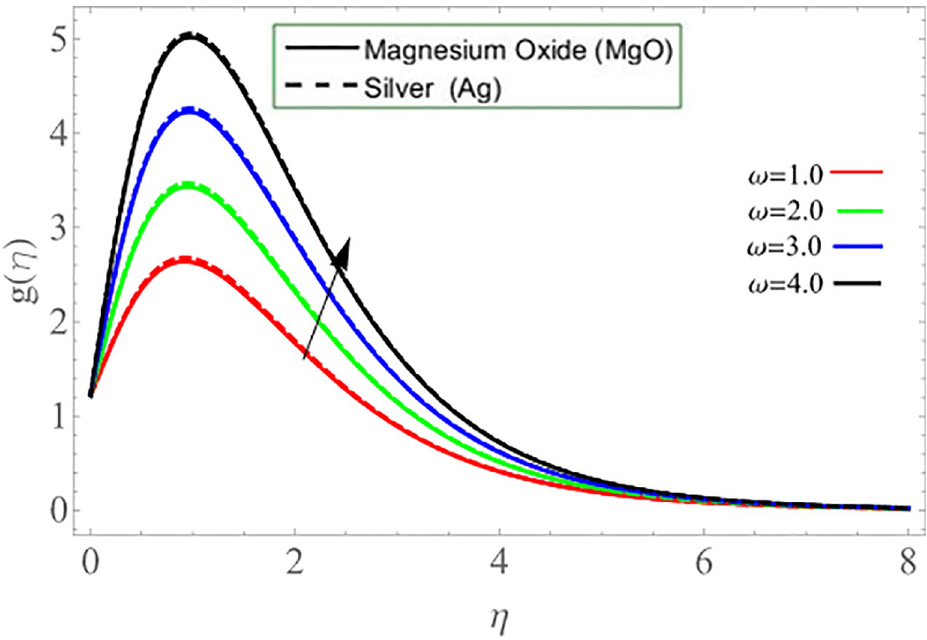
Table 1 elaborate the thermophysical characteristics of silver, base fluid, and magnesium- oxide. Table 2 revealed the comparison between PCM and bvp4c method numerically for all velocities. It can be presumed that the parametric continuation method has strong conver- gence versus other numerical method. Tables 3 and 4 display the influence of nanoparticles quantity ϕ on velocity radial and azimuthal direction, skin fraction and Nusselt number.